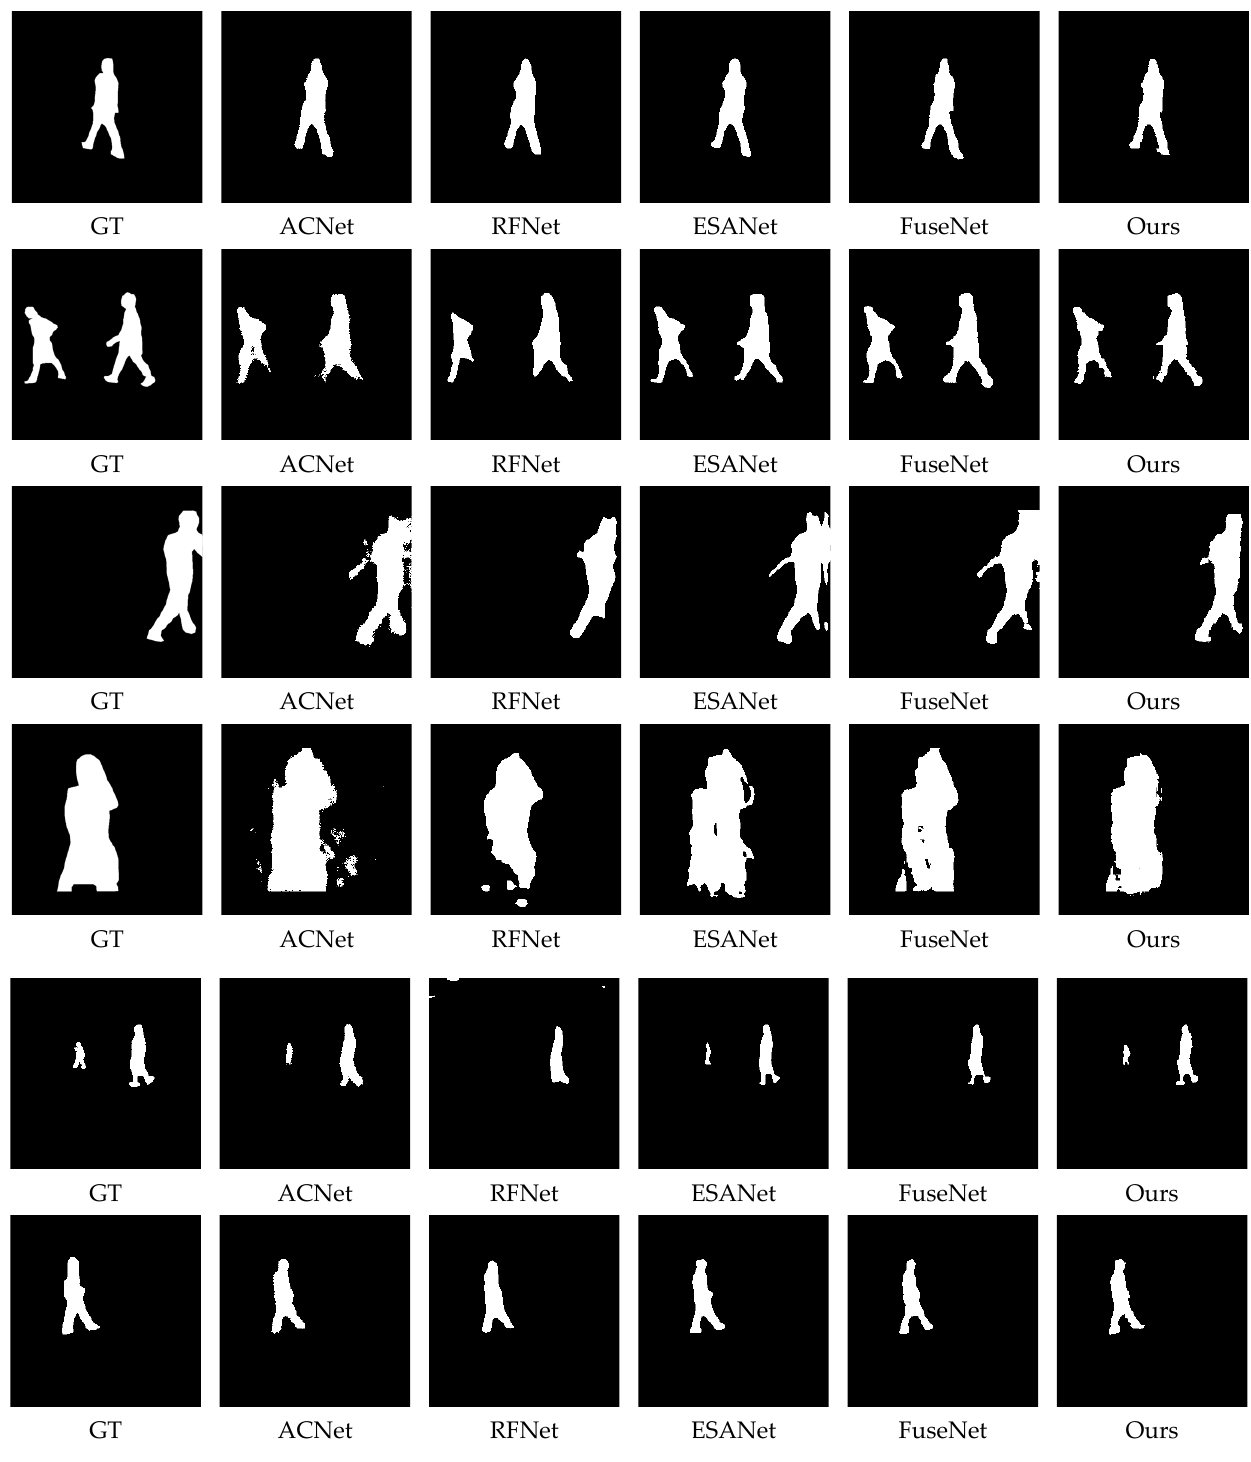
Figure 9. Experimental results compared with other methods. Table 3. The mIoU and global accuracy results of the comparison experiment.